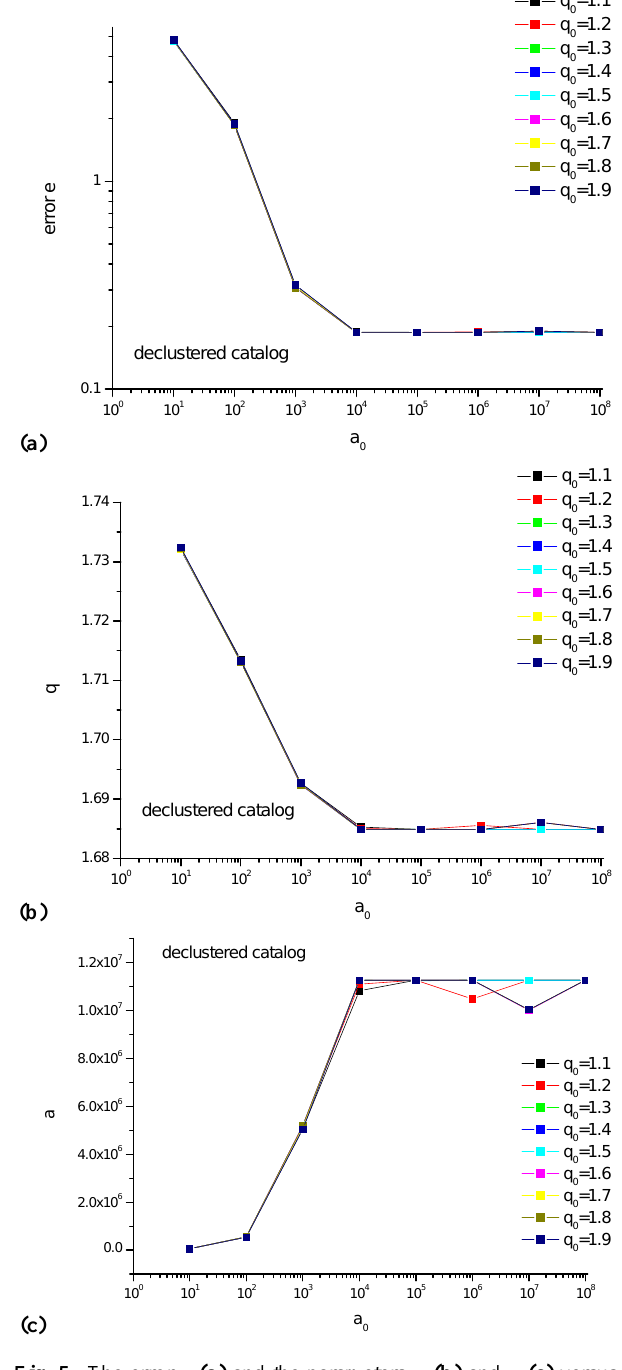
Fig. 5. The error e (a) and the parameters q (b) and a (c) versus initial value a 0 , calculated for the aftershock-depleted seismicity. The different colored curves are obtained with different values of q 0 . The error e shows an almost flat behavior for a 0 ≥ 10 4 and for any q 0 value. The parameters q and a were estimated as the mean of the obtained values for a 0 ≥ 10 4 , thus q =1.685 and a =1.1 × 10 7 (see text for